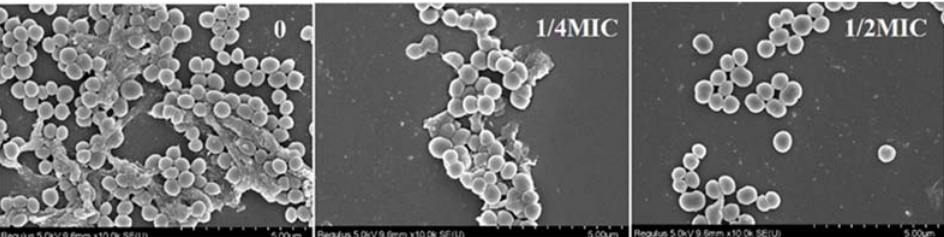
Figure 2. SEM images (×10,000) of S. aureus biofilms with 10-HDA treatment at the indicated con- centrations. concentrations.